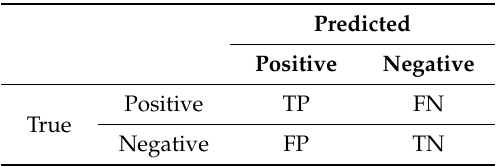
Table 1. The confusion matrix of a two-class